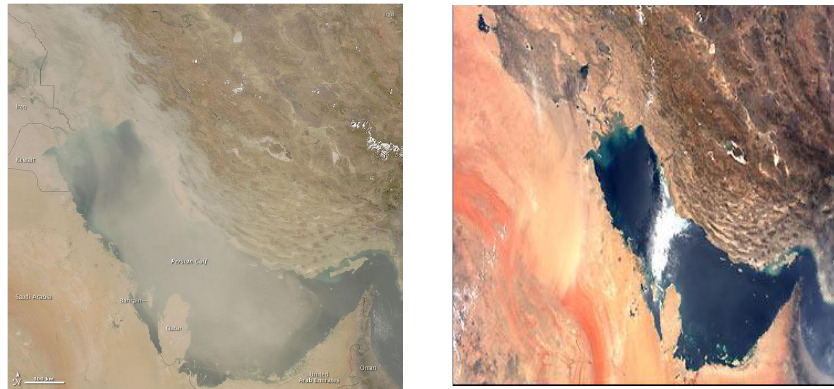
Figure 1. The ECO satellite image of Valdemar deployment in southwest Iran and the Persian Gulf. Due to data limitations (as a result of low depth and low intensity of research patrols) in this basin and the high sea border of Bushehr province with the Persian Gulf, for water sampling and measuring, the related parameters measured at the Bushehr Sea synoptic station, the Directorate of Meteorology of this province, located 12 km from the coastal line, were used. The region ’ s geographical location is such that the air masses from the South West and South are able to enter this region and leave special effects. In this study, to investigate the effect of dust phenomenon on WST, the July 2008 and 2009 was considered. In August 2008, the dust scattered slightly in the sky, and in July 2009, the phenomenon of the walnut was maximum. In this study, during the two months of 2008 and 2009, diagrams of correlation, time series, frequency distribution, and WST contour lines were compared to show the changes in WST due to the dust phenomenon. Excel, SPSS, and Surfer software were used for statistical analysis, graphics, and contour lines. 3. Results After data collection, field and satellite data were validated. For this purpose, the correlation of surface temperature with water and air temperature was first investigated through field and satellite measurements. To observe the scattering of field and satellite data, fitting lines and corresponding equations were obtained and the error rates were calculated [17]. The R 2 value was estimated as 0.9 which shows that there is a strong cor- relation between these two data. Therefore, a significant relationship was found between surface temperature (satellite) and field data, and the obtained errors between these data were found to be acceptable. There is a complete and direct correlation between field and satellite data. The same holds for air temperature value. After the surface temperature data modification of water and air temperature using the correlation equation, the surface temperature diagrams of spotting, air temperature, evaporation, radiation, and sunny watch were drawn. This is the most tangible effect of dust on the horizontal distance and the most significant of them were used for comparison. Based on data analysis, there was an indirect and part correlation between horizontal vision and WST. The surface temperature of water is strongly correlated with the wind direction and parameters such as evaporation and sunshine hour and this is because the effects of sev- eral parameters on WST are dependent together and sometimes the effects of one of them on water surface eliminate another. To determine and compare surface temperature, air temperature, horizontal vision, speed and direction of wind, evaporation, radiation and sunny hour during the 2008 to 2009 years on the shores of Bushehr province, the related